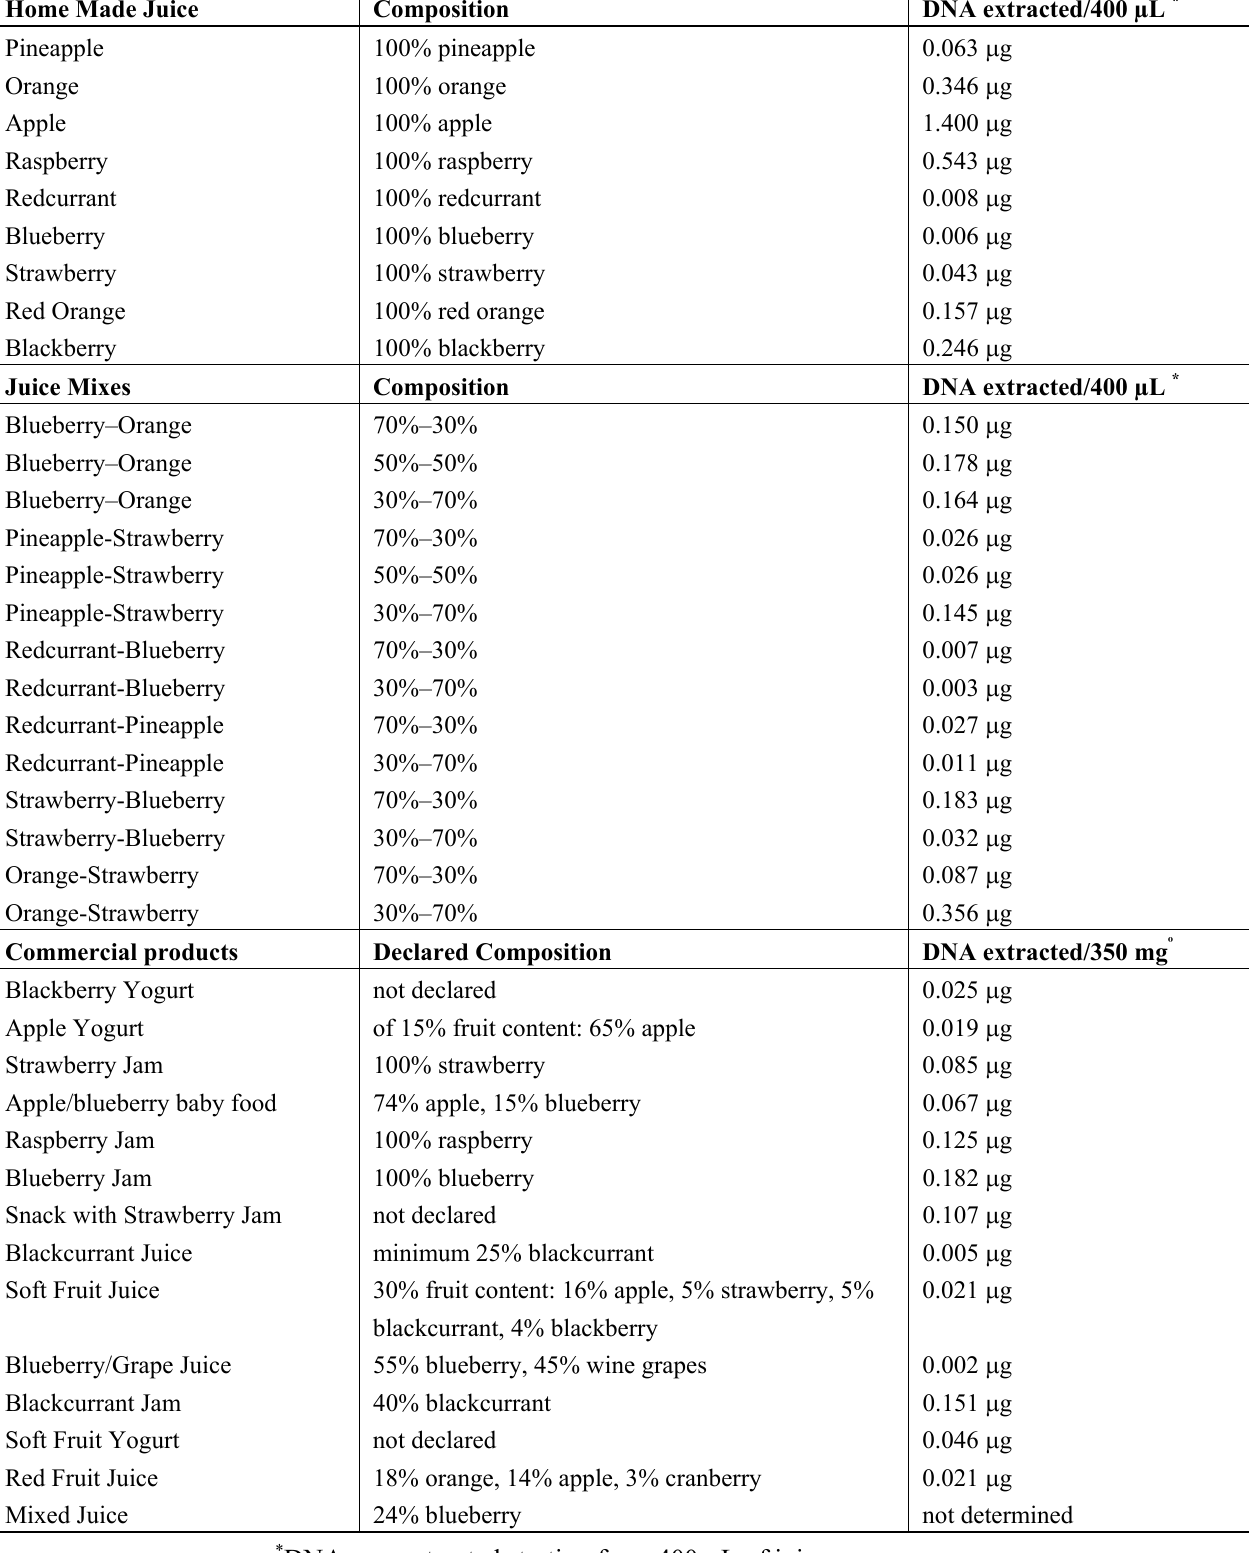
Table 1. Sample list and quantity of DNA